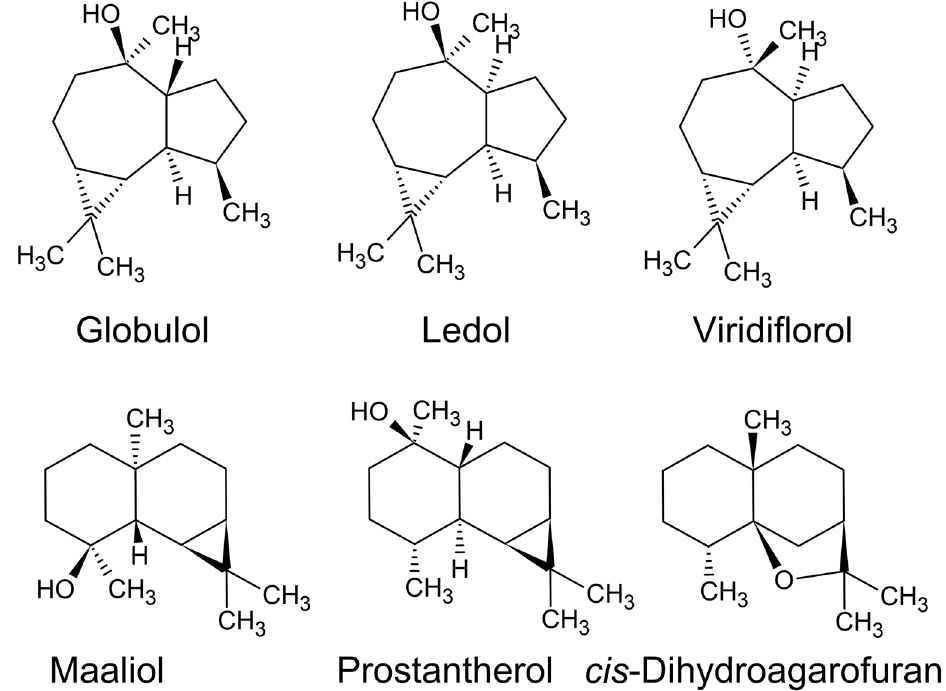
Figure 8. Sesquiterpene epimers and structurally related derivatives that can be difficult to differentiate by mass spectral patterns alone.